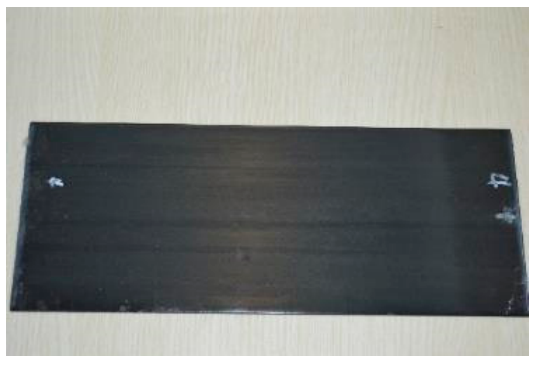
Figure 2. Adhesive coated CFRP plate.